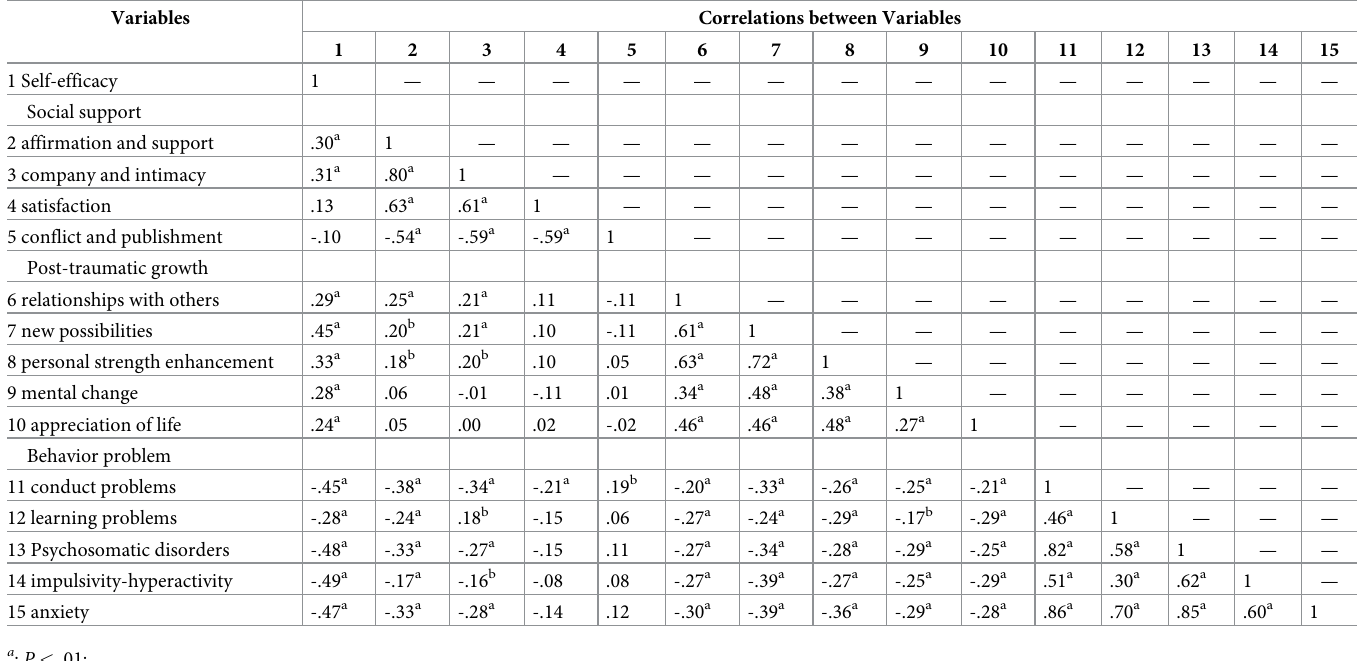
Table 2. Correlation between observed indicators of latent variables (N =